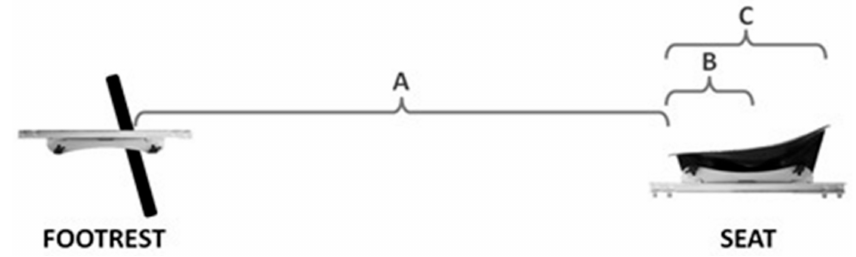
Figure 1. Measurements of the